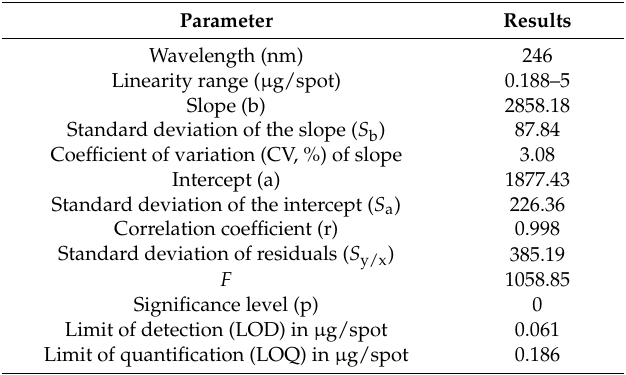
Table 2. Linear model and statistical parameters of calibration curve y = a +